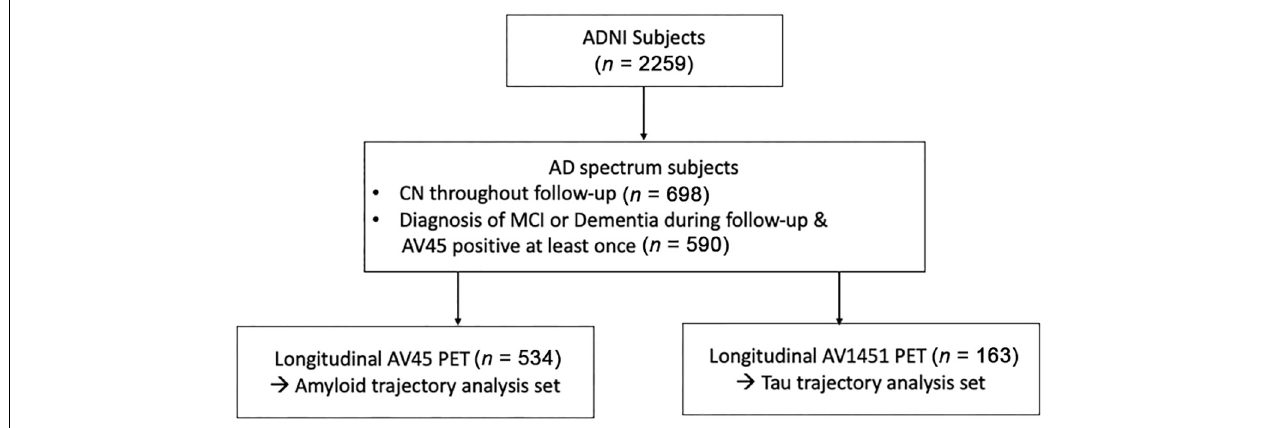
FIGURE 1 | Flowchart of enrolled participants within the study. Abbreviations: ADNI, Alzheimer’s disease neuroimaging initiatives; AD, Alzheimer’s disease; MCI, mild cognitive impairments; CN, cognitively normal; PET, positron emission